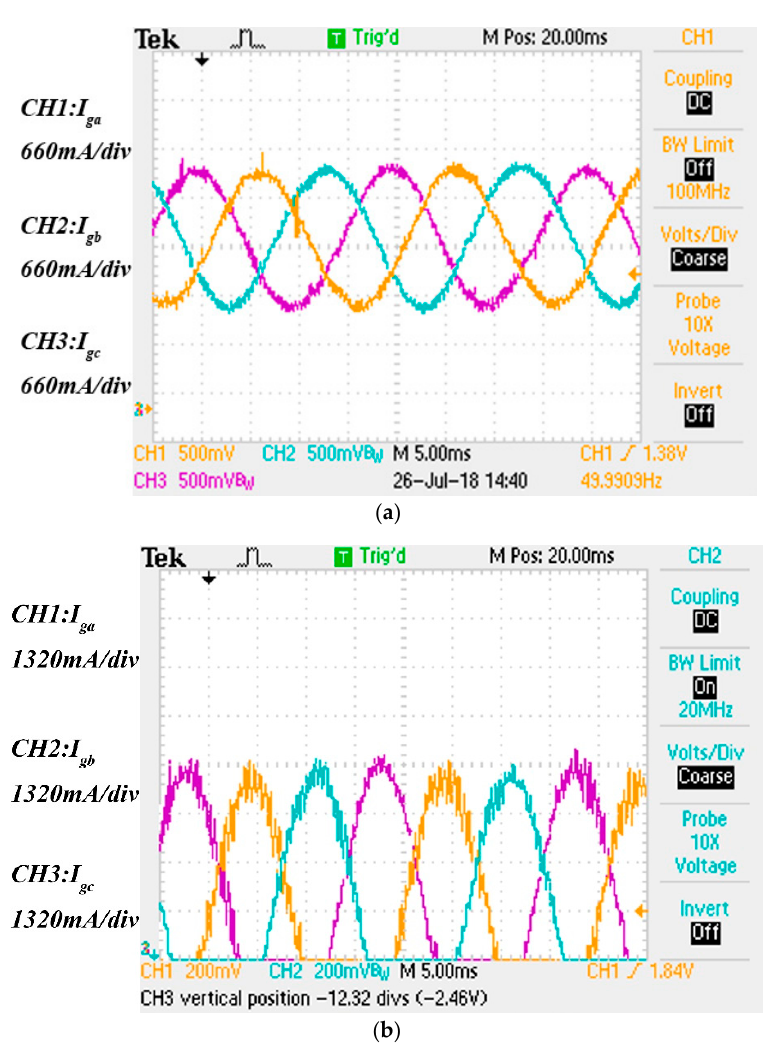
Figure 11. Waveforms of grid current with dc components at different current reference with the proposed scheme. ( a ) i dref = 1 A. ( b ) Zoom-in detail of Figure